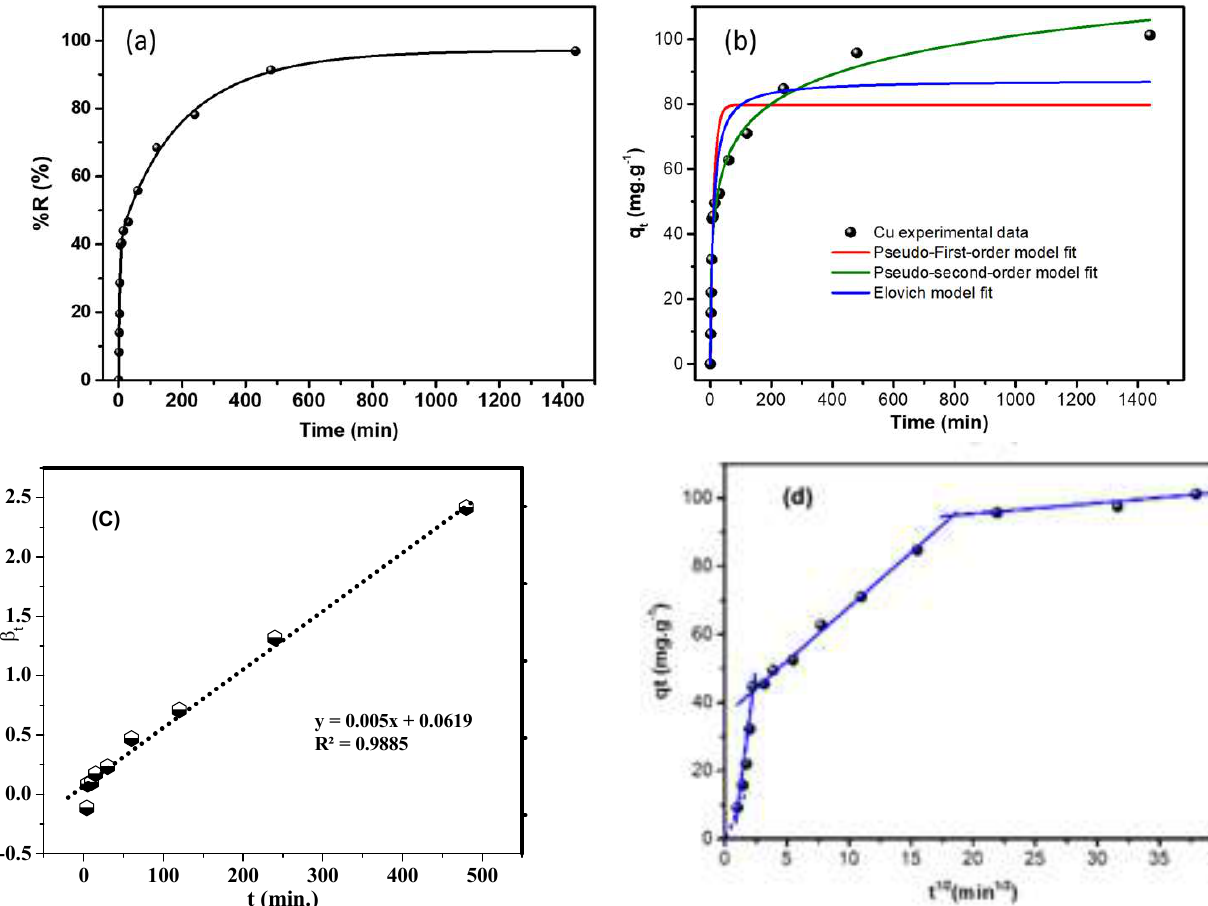
Figure 3. ( a ) Impact of adsorption time and ( b ) fitting experimental data with different nonlinear kinetics models; ( c ) Boyd model and ( d ) IPDT model for Cu 2+ metal ion uptake onto the sorbent Zr-G-C 3 N 4 , using a nonlinear trend.